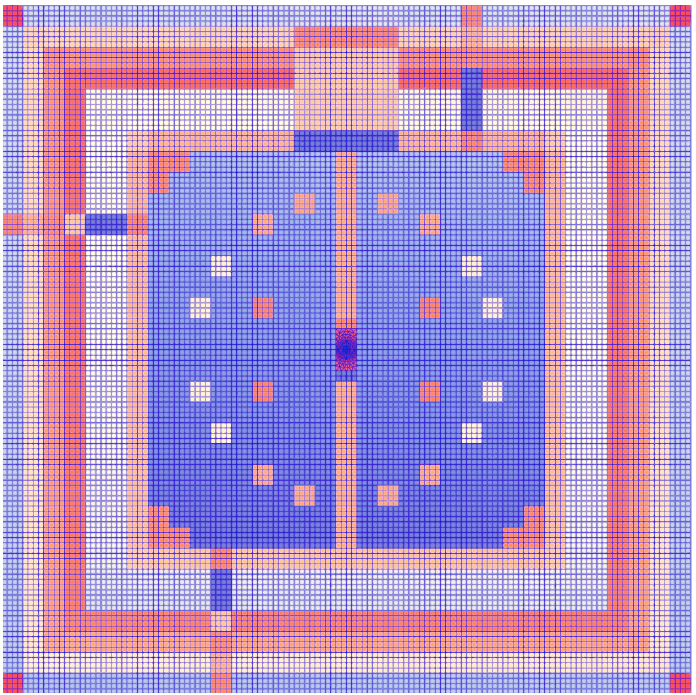
Figure 7. X–Y view of the 19-by-19 TREAT array mesh with the hodoscope hole, with the SIRIUS-CAL experiment located in the center.